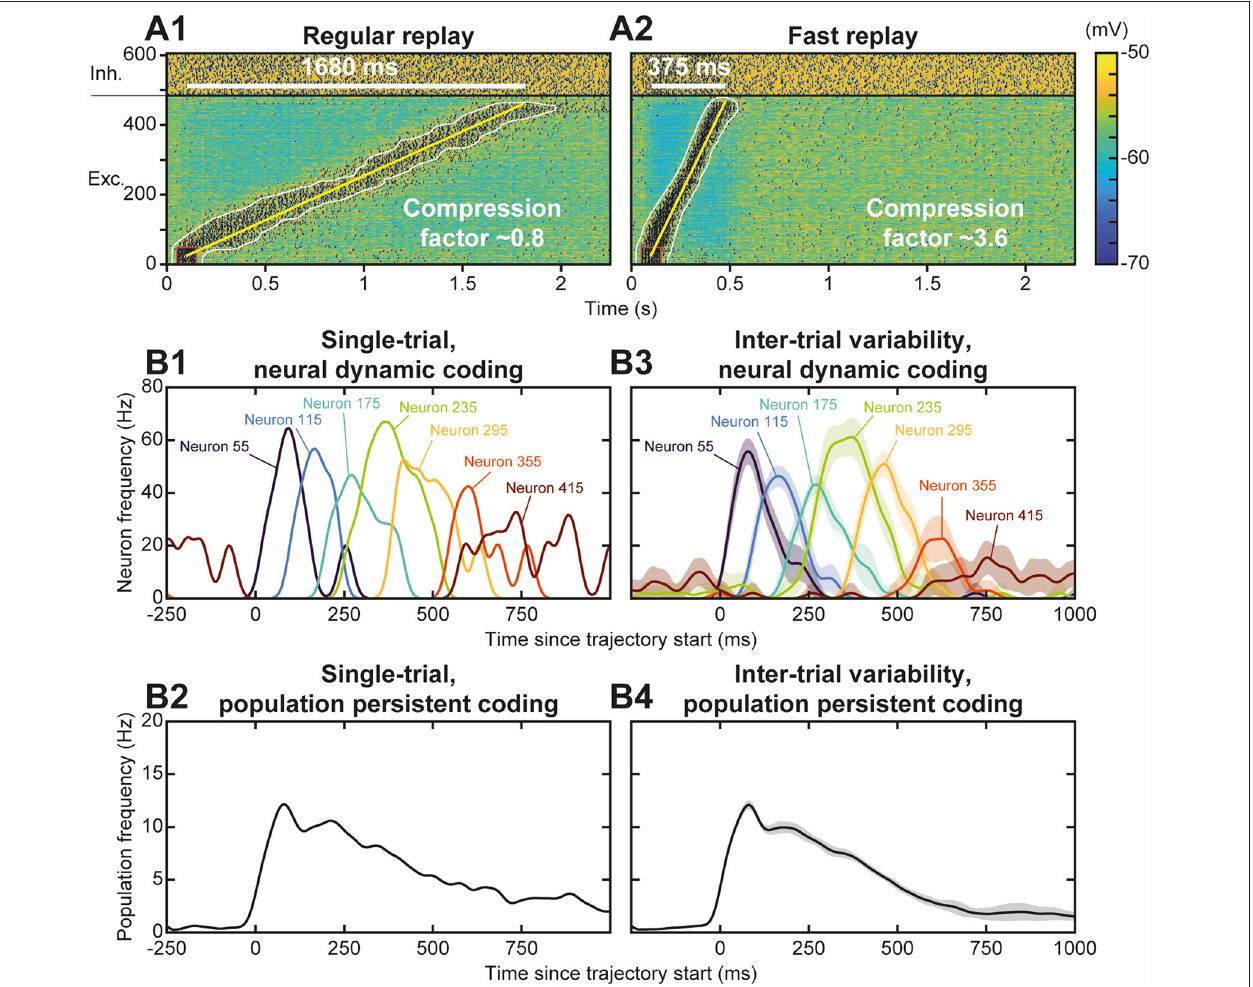
FIGURE 5 | Functional diversity of trajectory replays. (A) Trajectory replay duration (upper left white bar) and compression factor (tCF; lower right) depend on the NMDA conductance decay time constant ( τ NMDA , range 30–150ms). NMDA maximal conductance was scaled (range 0.475–1.8) so as to insure similar levels of firing frequency drive during trajectory replays. Regular (A1) and fast (A2) timescale replay are due to slower and faster NMDA dynamics. (B) . Single-trial (B1, B2) and inter-trial variability (B3,B4) of firing frequency of individual neurons (B1,B3) and of the population (B2,B4) for 10 different simulations similar to the replay shown Figure 4B . Lines represent mean values, shaded regions represent 95% confidence intervals of the